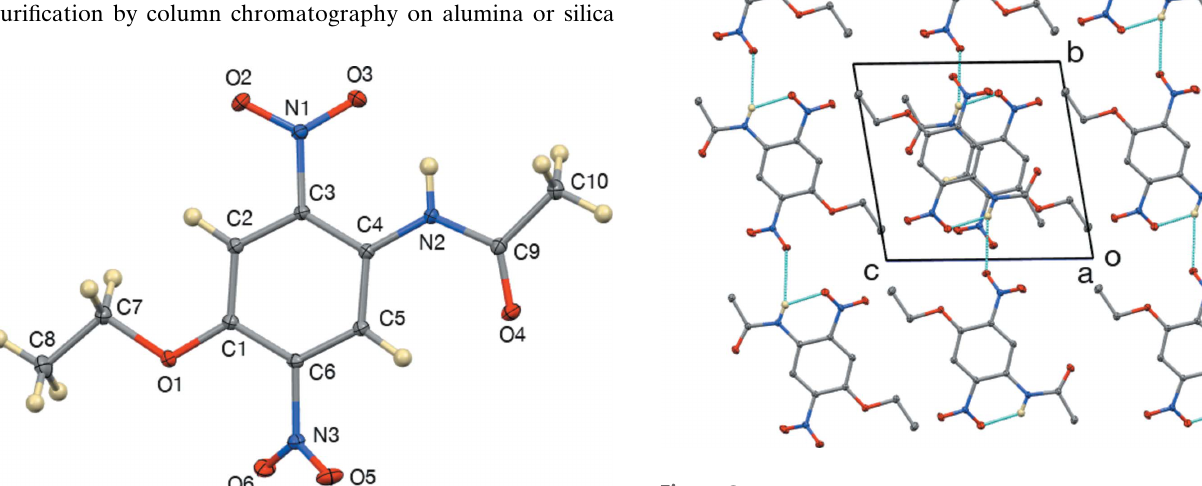
Figure 2 The unit cell viewed down [100], showing hydrogen bonds as blue lines. C—H hydrogen atoms are not shown.